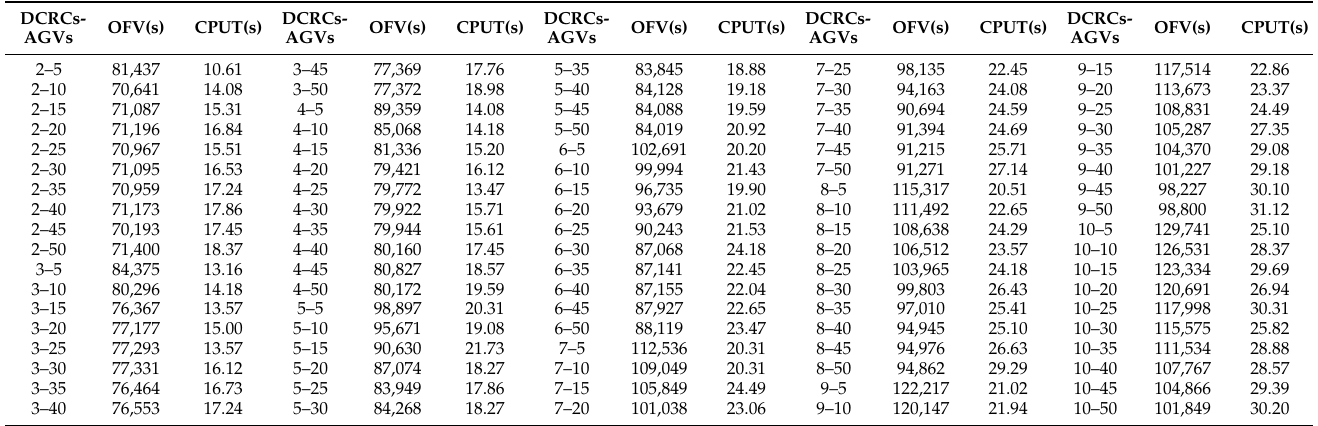
Table 3. Calculation example of 1 QC.